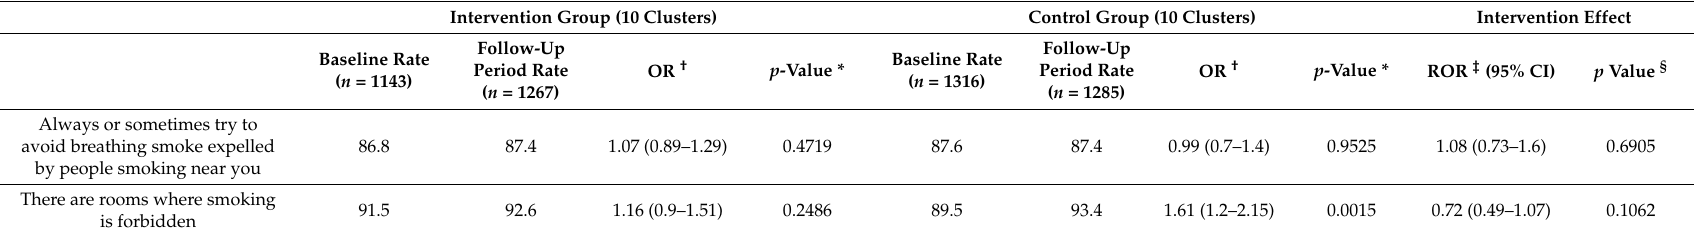
Table 3. Effect of the intervention on secondhand smoke exposure on attitudes for non-smokers and